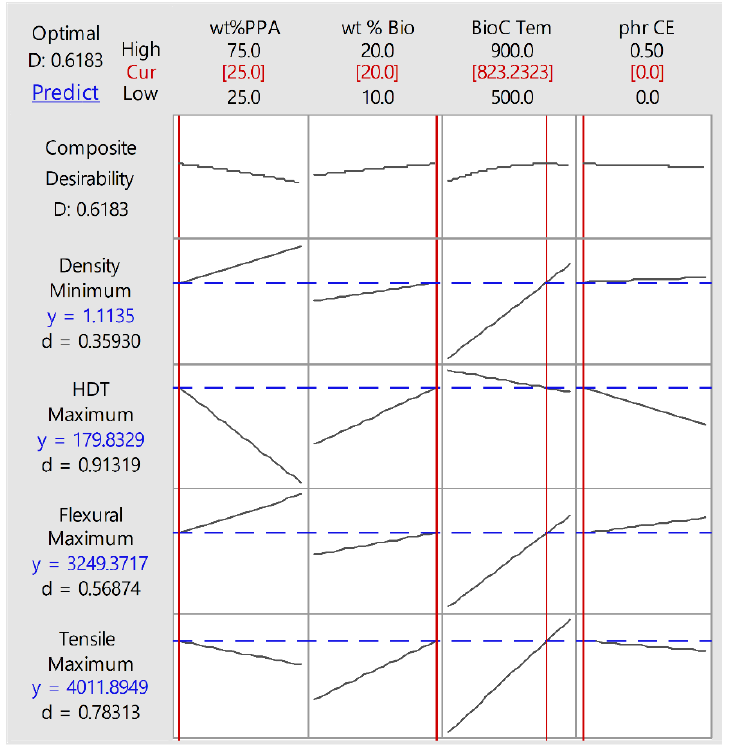
Figure 6. Optimization plot of material space considered.